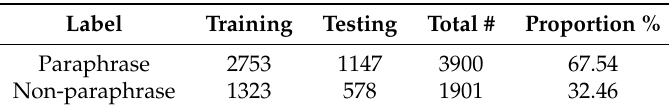
Table 3. Splits of the MSRP Corpus.